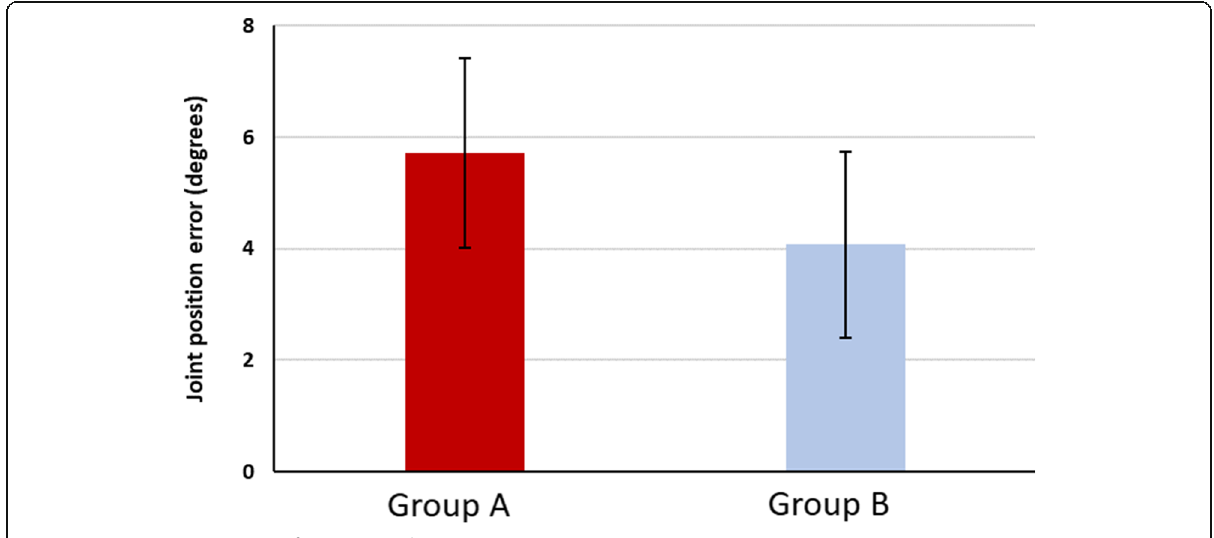
Fig. 1 Mean joint position error of groups A and